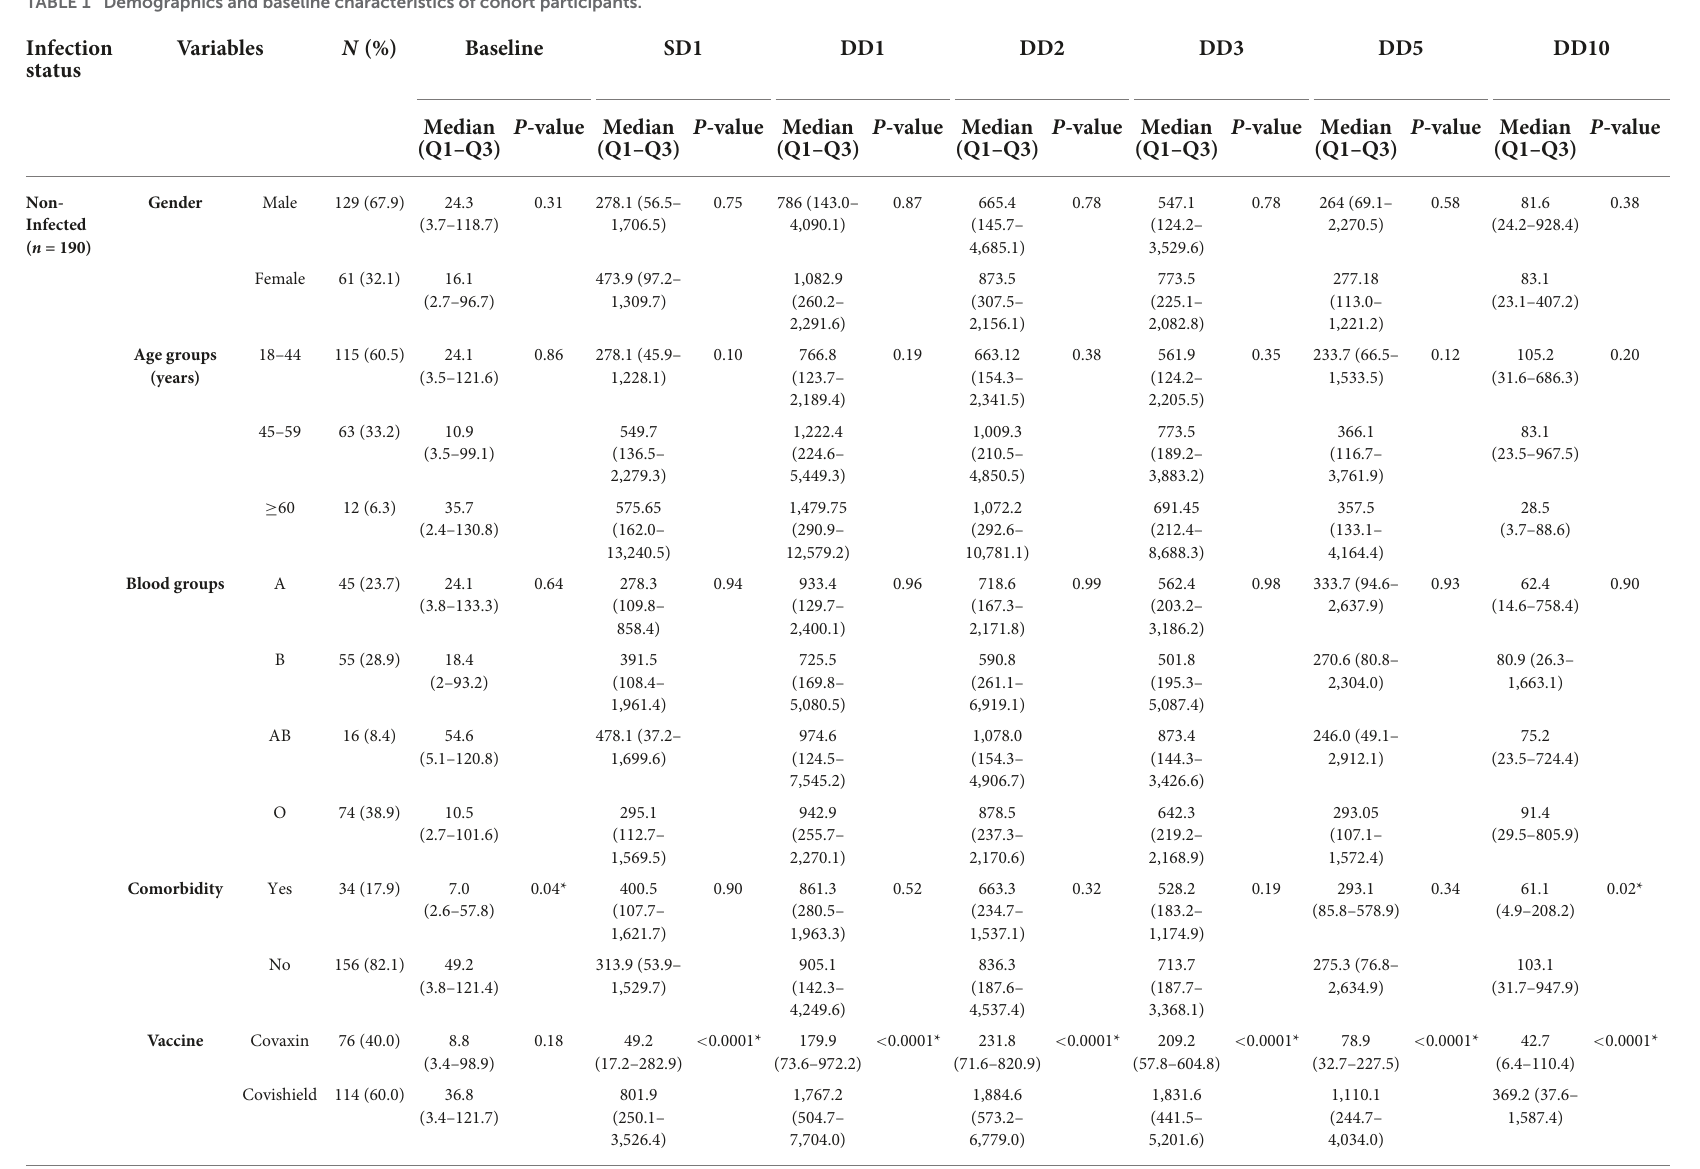
TABLE 1 Demographics and baseline characteristics of cohort